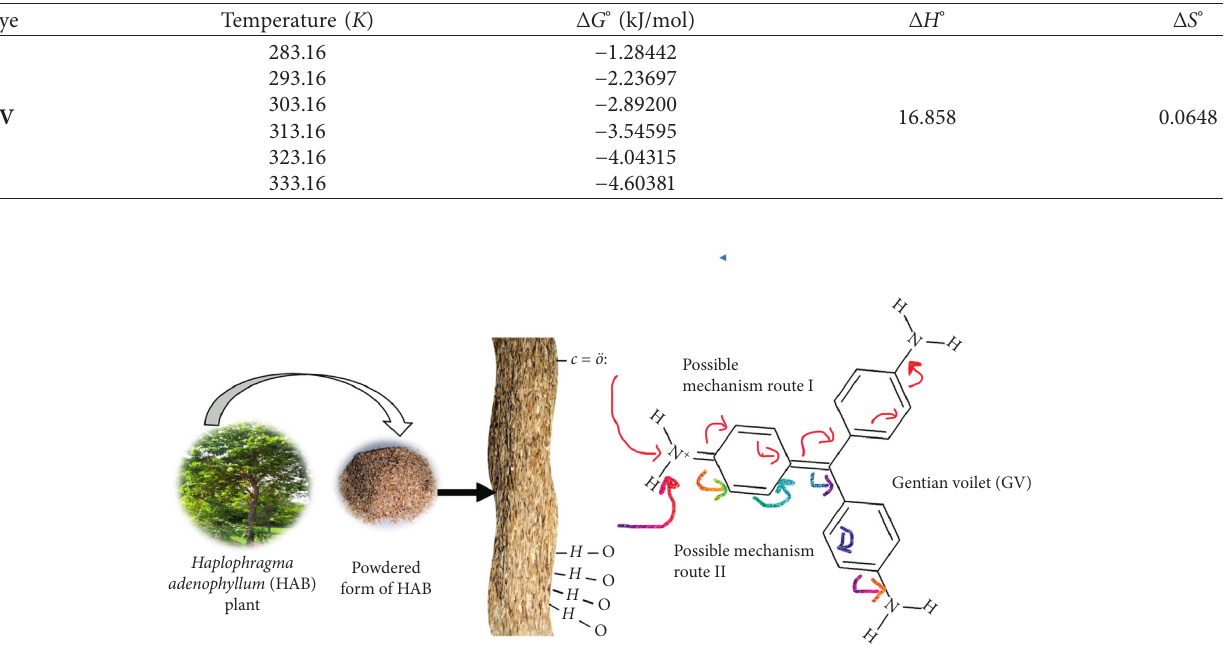
Table 4: Thermodynamics parameters for removal of